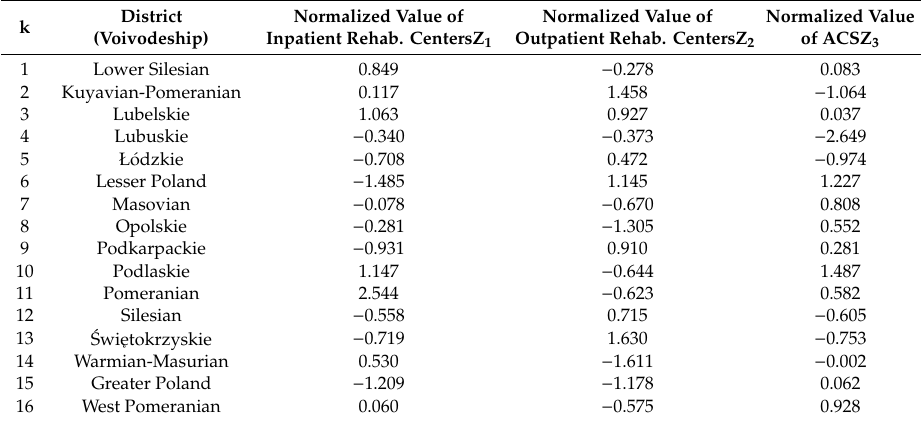
Table 3. Normalized values of variables used in the research.